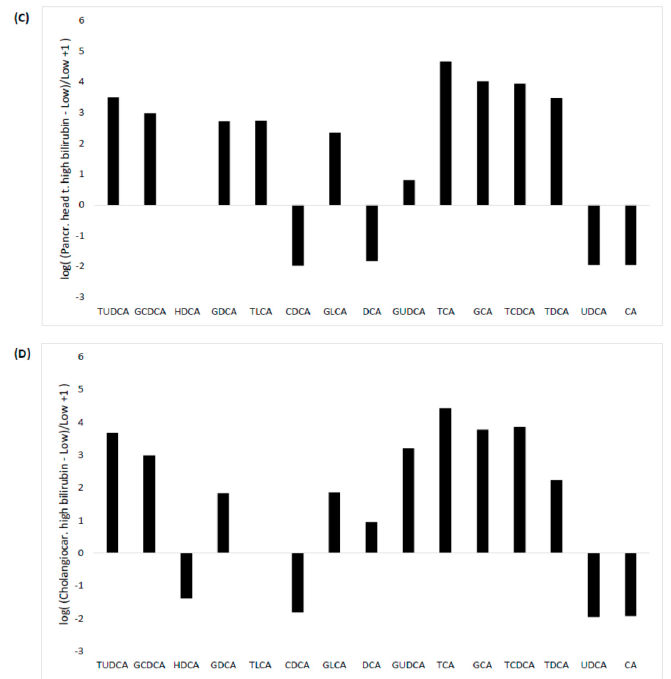
Figure 3. Influence of hyper-cholesterolemia and hyperbilubinemia on BA profile. Comparison between the hyper-cholesterolemic pool and the pool from normo-cholesterolemic subjects ( A ). Comparison between the normo bilirubiunemic pool and the hyperbilirubinemic pools from biliary stones ( B ), pancreatic head tumor, ( C ) and cholangiocarcinoma ( D ) patients.